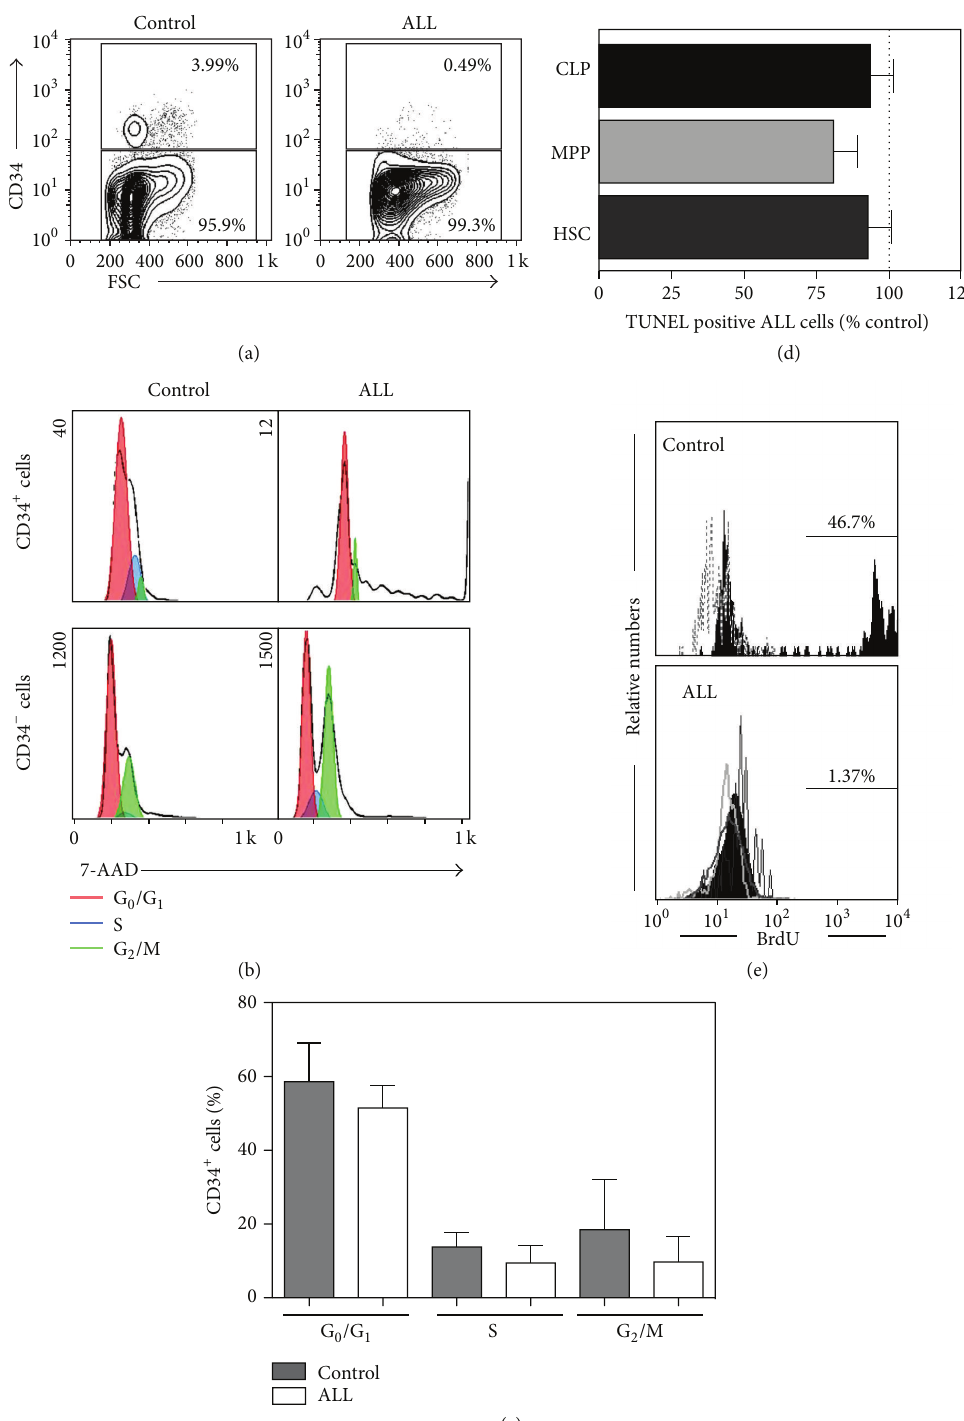
Figure 3: Normal apoptosis rates but poor proliferative capabilities mark the early steps of lymphoid development in ALL. Mononuclear cells from control and ALL bone marrow (BM) were fractionated according to CD34 expression and analyzed by flow cytometry (a). The cell cycle status of primitive CD34 + cells and of CD34 − maturing cells (as indicated from the flow cytometry gates) were examined by 7-AAD staining (b). The CD34 + cell frequencies in G 0 /G 1 , S, and G 2 /M phases of the cell cycle were tabulated (c). Apoptosis rates in highly purified HSC, MPP, and CLP populations were assessed by TUNEL (d), while the proliferative disadvantage in the total fraction of progenitor cells in ALL BM was highlighted by means of BrdU incorporation in stromal cell-free conditions (e). HSC: hematopoietic stem cells; MPP: multipotent progenitor; CLP: common lymphoid